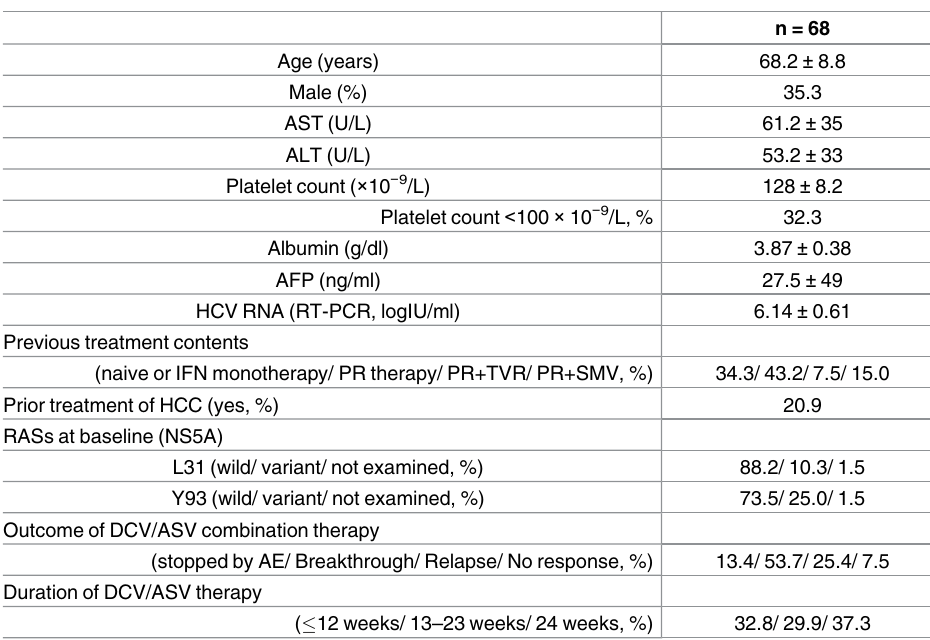
Table 1. Baseline